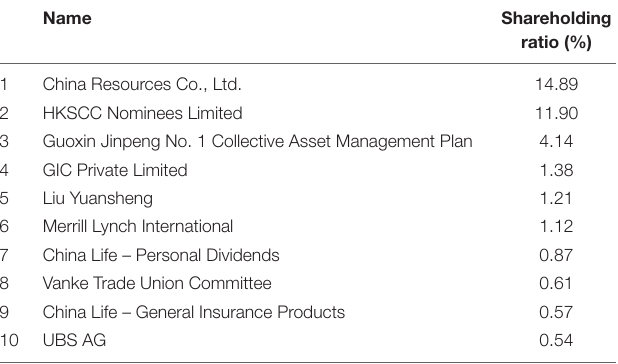
TABLE 6 | Top 10 shareholders of Vanke before June 30,